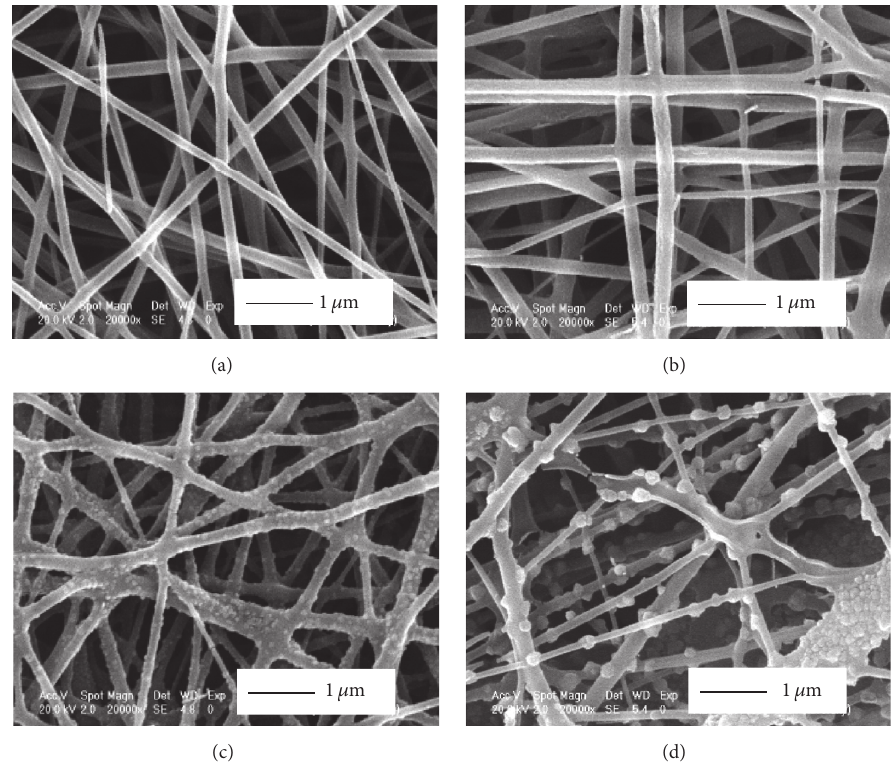
Figure 1: SEM images showing ZnO-PVA nanofibrous membranes with 0.1mM (a), 1mM (b), 5mM (c), and 10mM (d) zinc